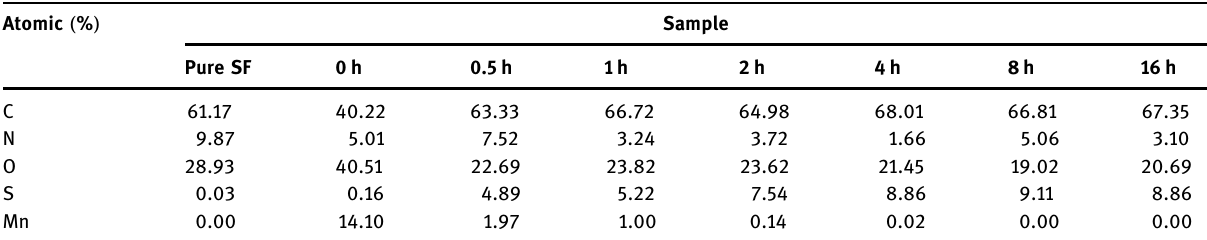
Table 1: Surface elemental compositions of SF/PEDOT membrane prepared at di ff erent time Atomic ( % ) Sample